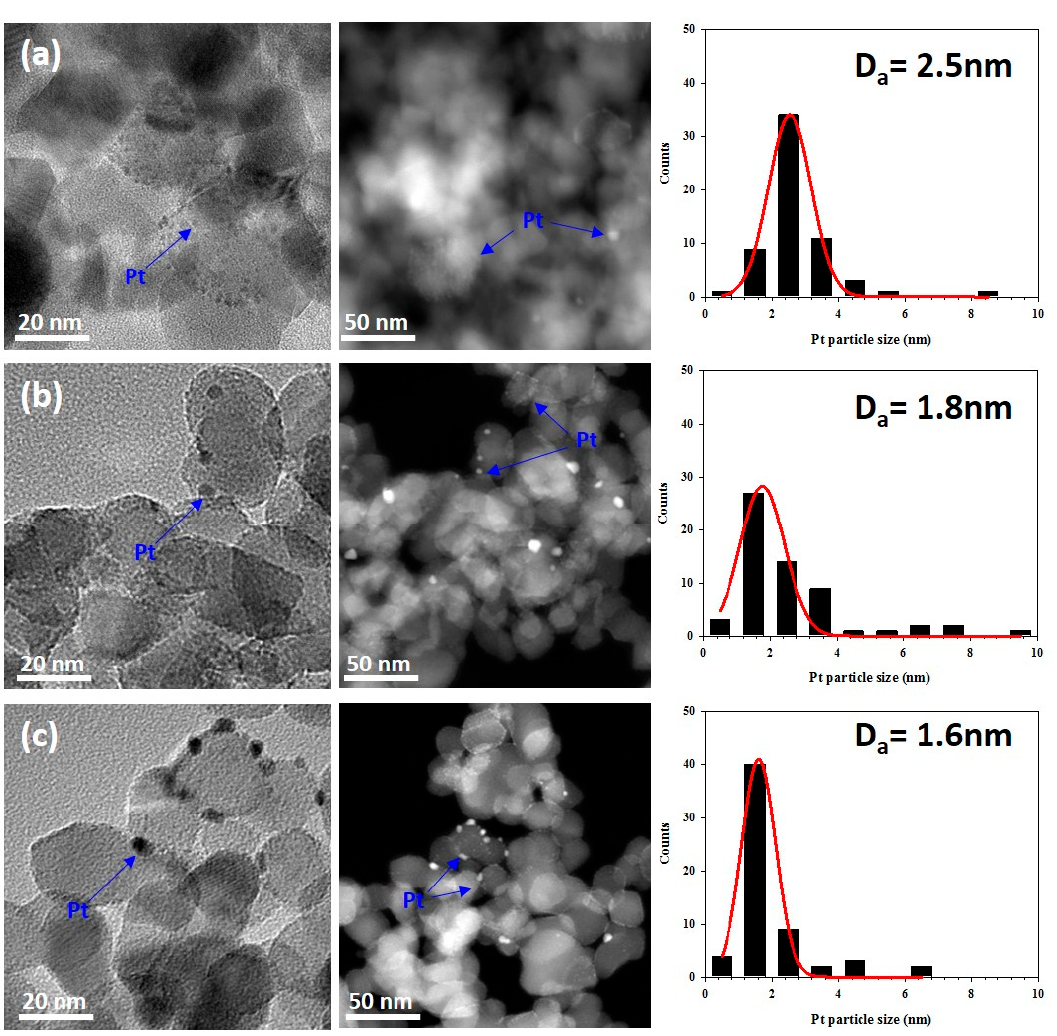
Figure 2. FE-TEM and S-TEM images and platinum particle size distributions of Pt–W[x]/TiO 2 catalysts: ( a ) Pt–W[0]/TiO 2 , ( b ) Pt–W[3]/TiO 2 , and ( c ) Pt–W[7]/TiO 2 .